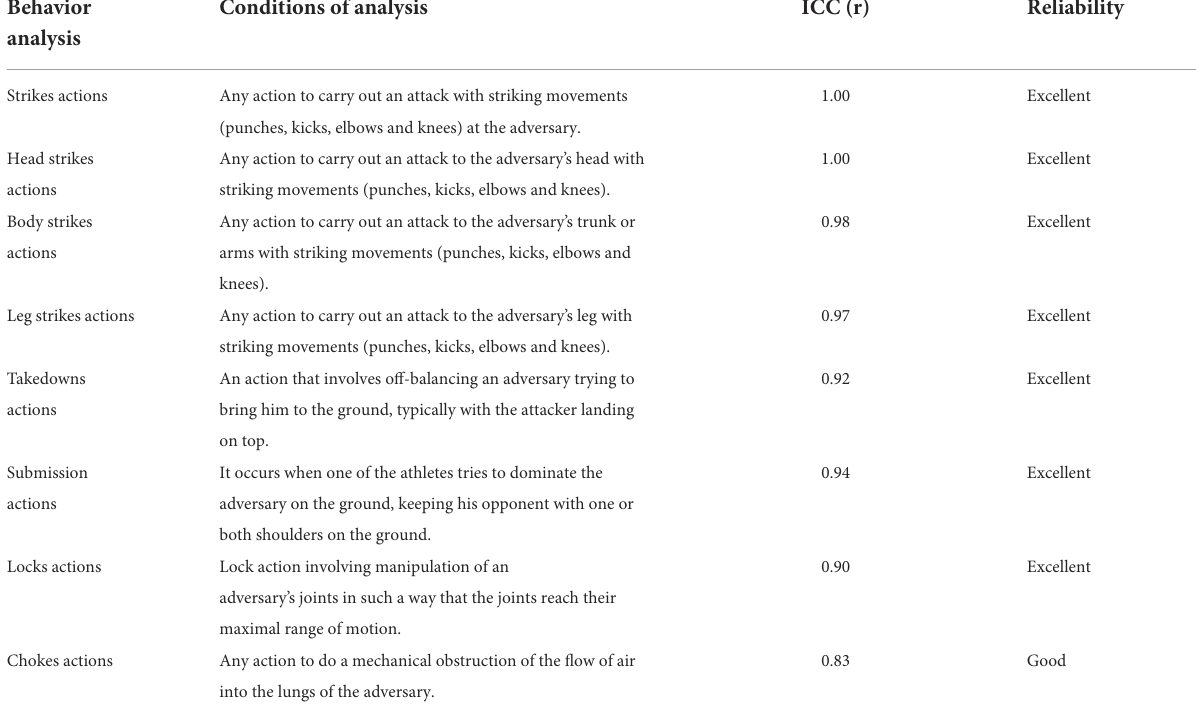
TABLE 1 Criteria of technical-tactical analysis from MMA performances and intraclass coefficient of correlations.